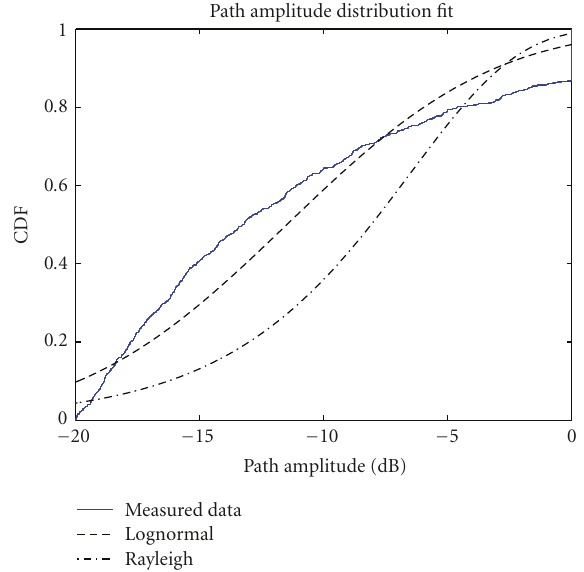
Figure 17: Path amplitudes CDF with the best-fit Rayleigh (RMSE = 0.2078) and lognormal (RMSE = 0.0726) distributions for measurements beneath the Escalade chassis.